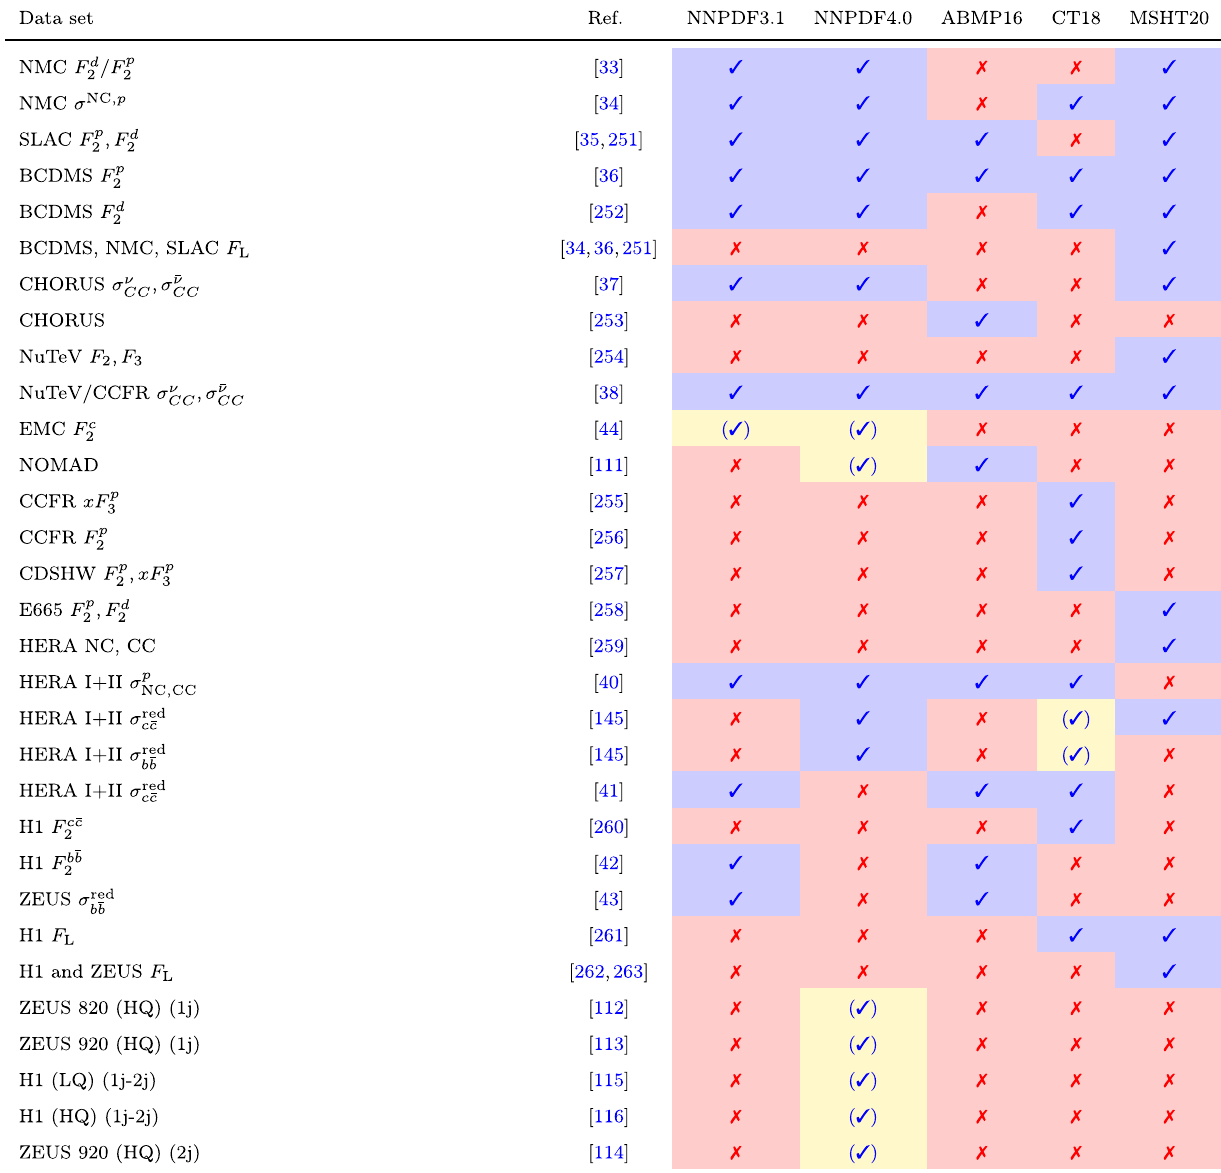
Table 33 The fixed-target and collider DIS measurements used for PDF determination. For each PDF set, a blue tick indicates that the given dataset is included and a red cross that it is not included. A